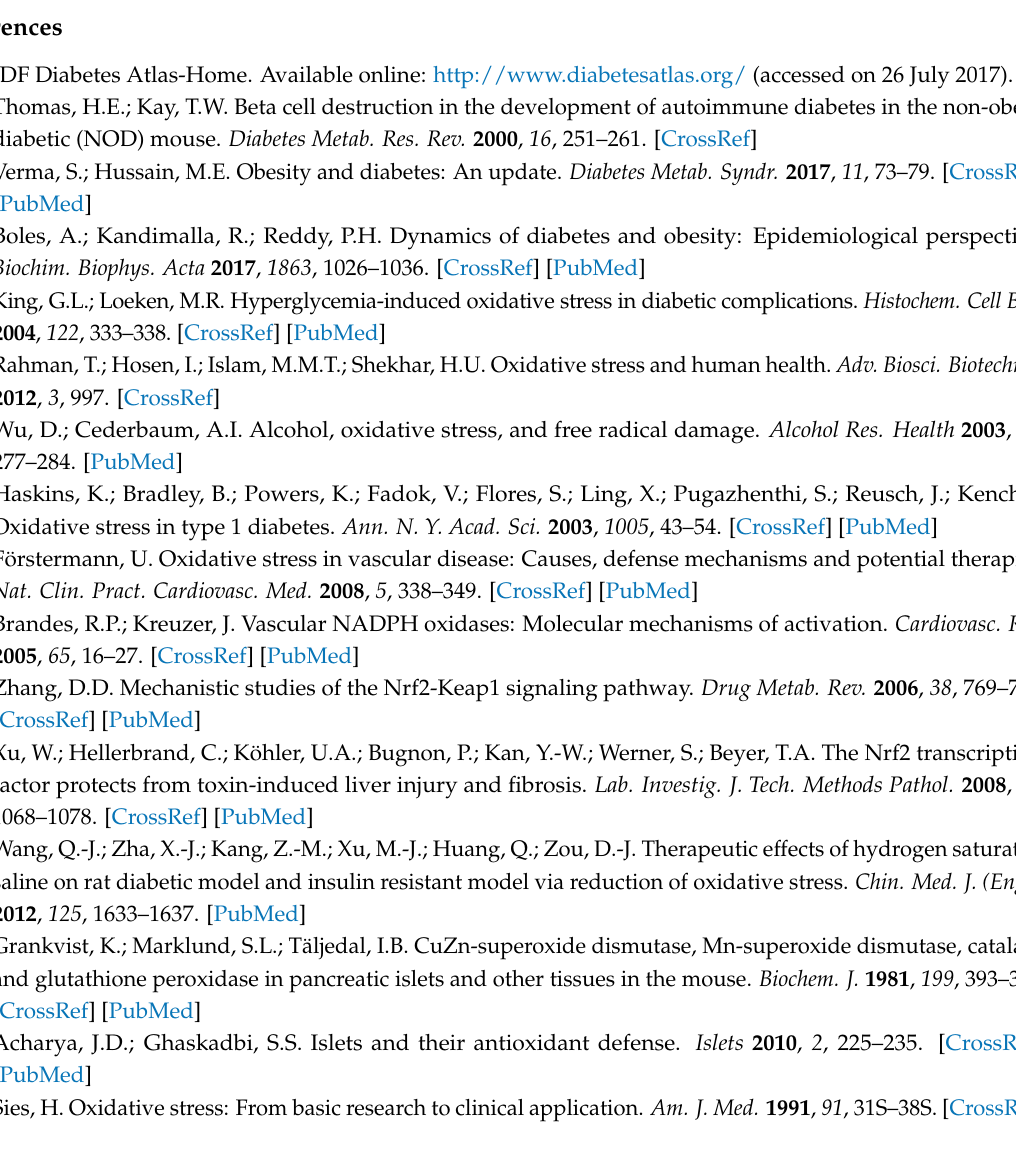
Figure S1. Schematic representation of (A) the toxicity test (B) the toxicity test after fructose stress, Figure S2. Chromatogram of aqueous 2 jojoba seeds extract, Figure S3. Effect of simmondsin and aqueous extract on fructose induced-oxidative